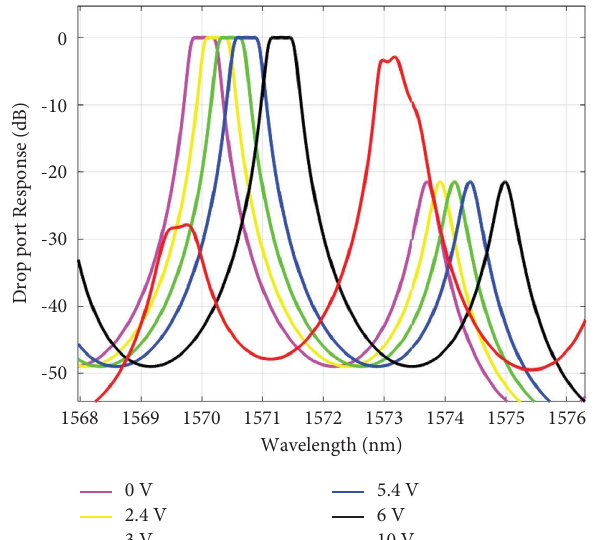
Figure 9: Electro-optically tuned add-drop flter. Te thickness and the scattering rate for the graphene layer are t respectively. Te resonance wavelength shifts from the original value of 1570nm (magenta curve) as a function of the tuning voltage ( V G ) varying from 0 to 12V. Te fuctuations in the amplitude response are observed beyond the breakdown voltage (red curve).